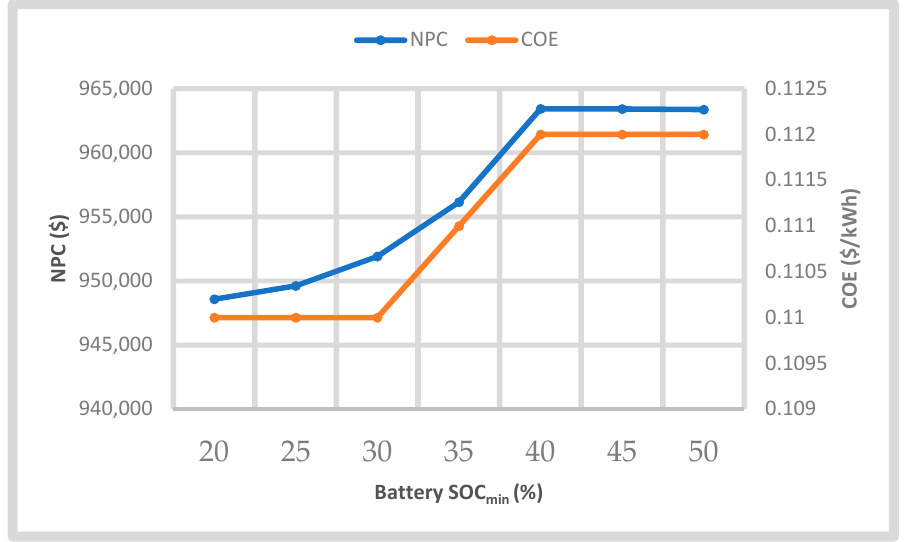
Figure 19. Impact of the battery minimum state of charge (SOC min ) on the system total NPC and COE.